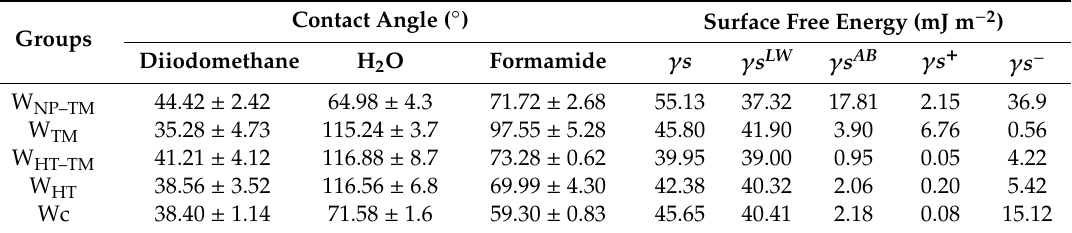
Table 2. Contact angle and surface free energy of untreated and treated poplar.